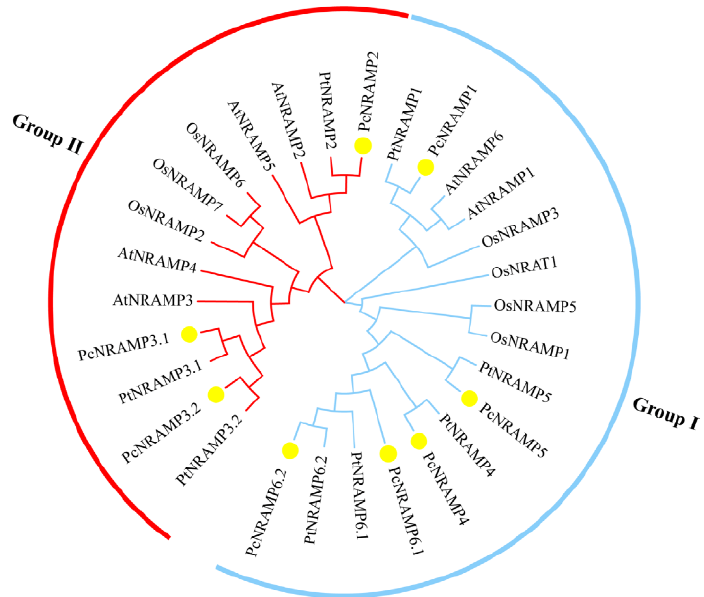
Figure 1. Phylogenetic analysis of NRAMP proteins in P . × canescens (Pc), P. trichocarpa (Pt), A. thaliana (At) and O. sativa (Os). Blue and red branches represent group I and II, respectively. PcNRAMP proteins are marked with yellow filled circles. Accession numbers of NRAMP proteins are listed in Table S2.